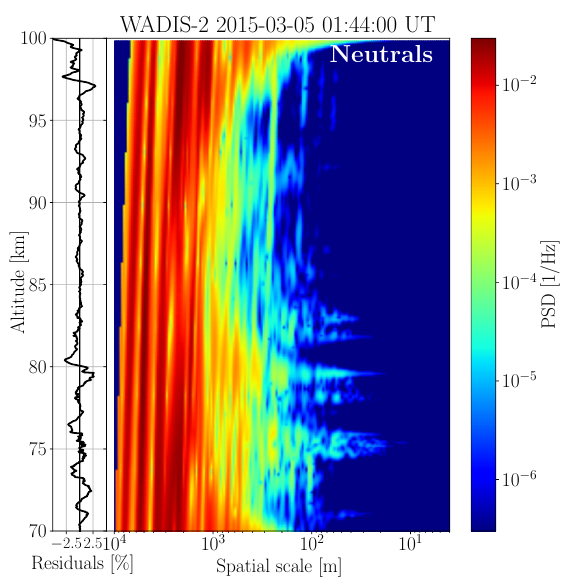
Figure 10. The same as Fig. 9 but for neutral